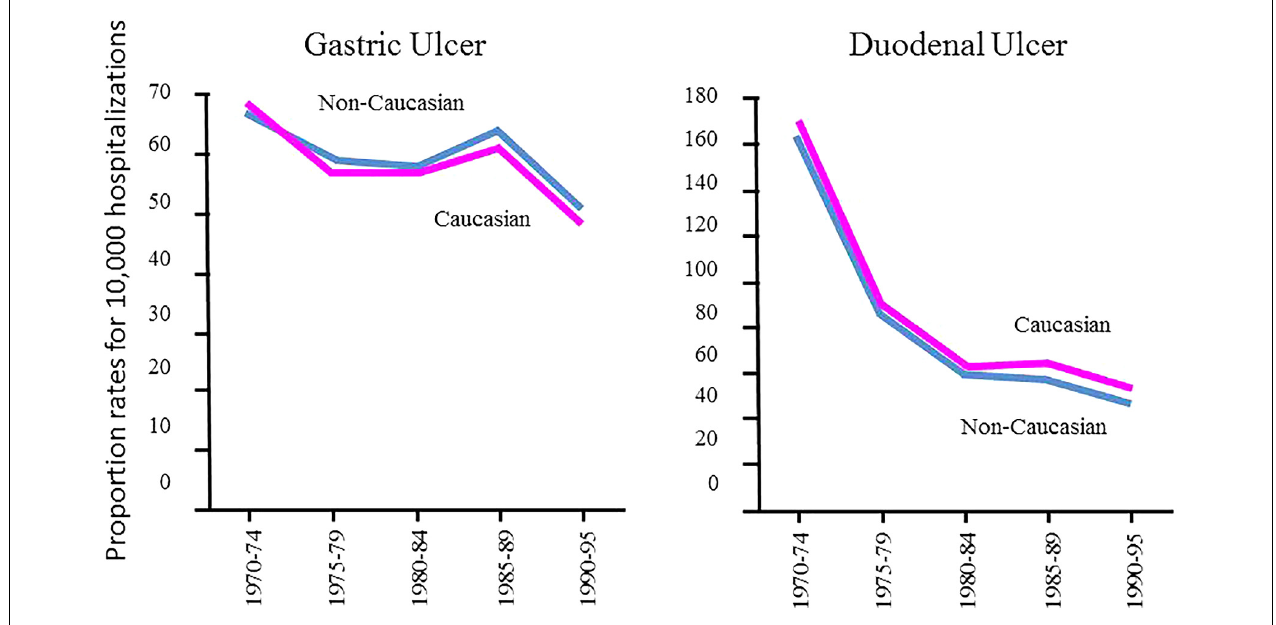
FIGURE 3 | Gradual decline in gastric and duodenal ulcer diseases associated to H. pylori infection in Caucasian and non-Caucasian men using the US Department of Veterans Affairs database from 1970 to 1995, prevalence shown as the proportional rate per 10,000 hospitalizations and the Vital Statistics of the United States obtained by the National Center of Health Statistics (NCHS) (El-Serag and Sonnenberg, 1998).